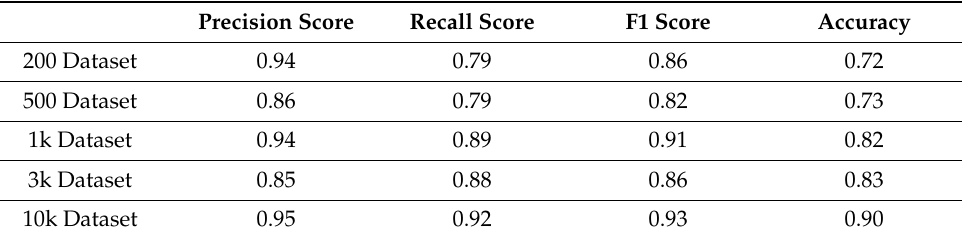
Figure 10. KNN performance results according to the size of the dataset. Table 8. Results of the CNN.